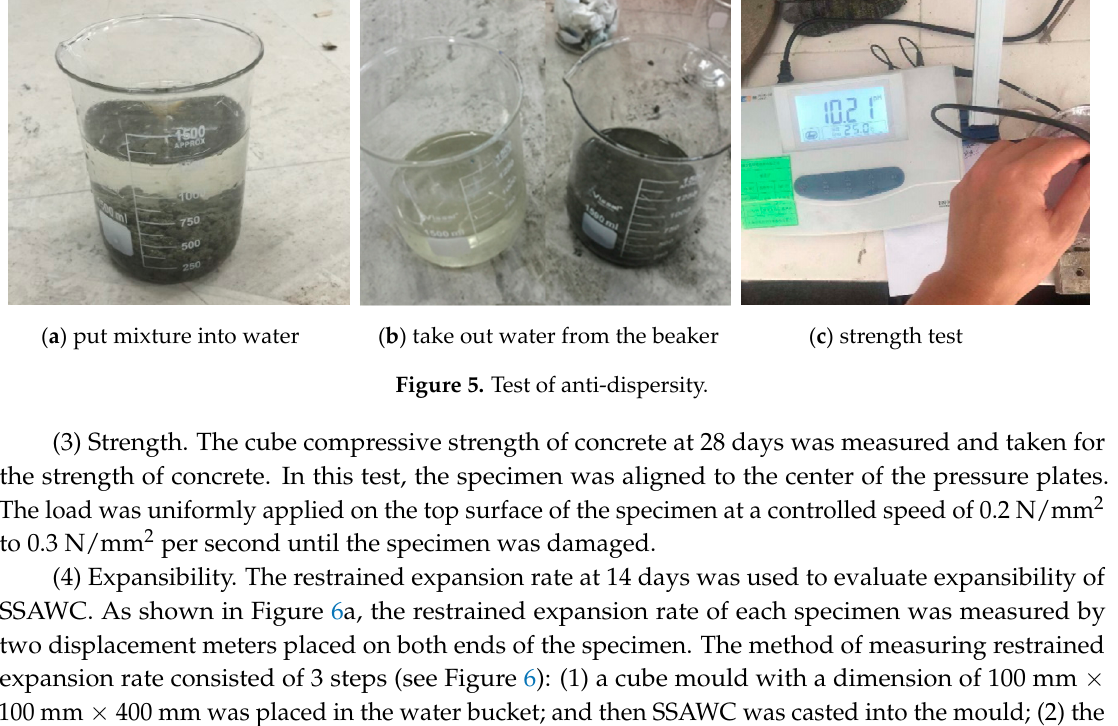
Figure 6. Test of expansive.